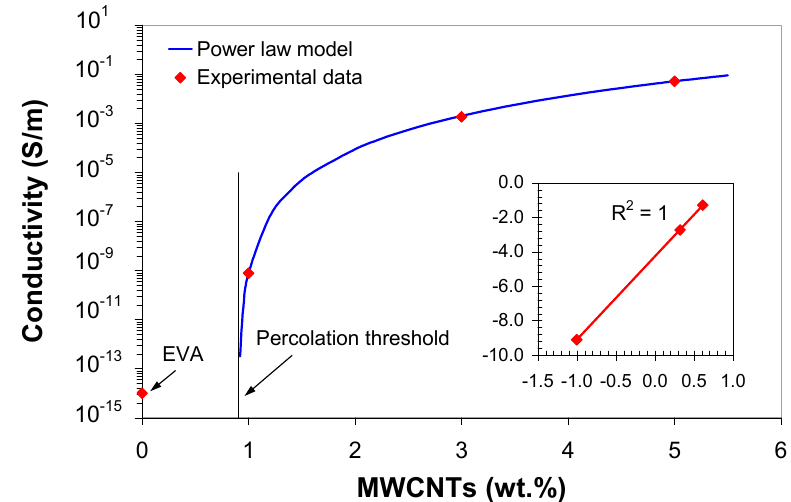
Figure 15. Variation of electrical conductivity as a function of MWCNT wt.% (Experimental data correspond to the optimum injection molding parameters).